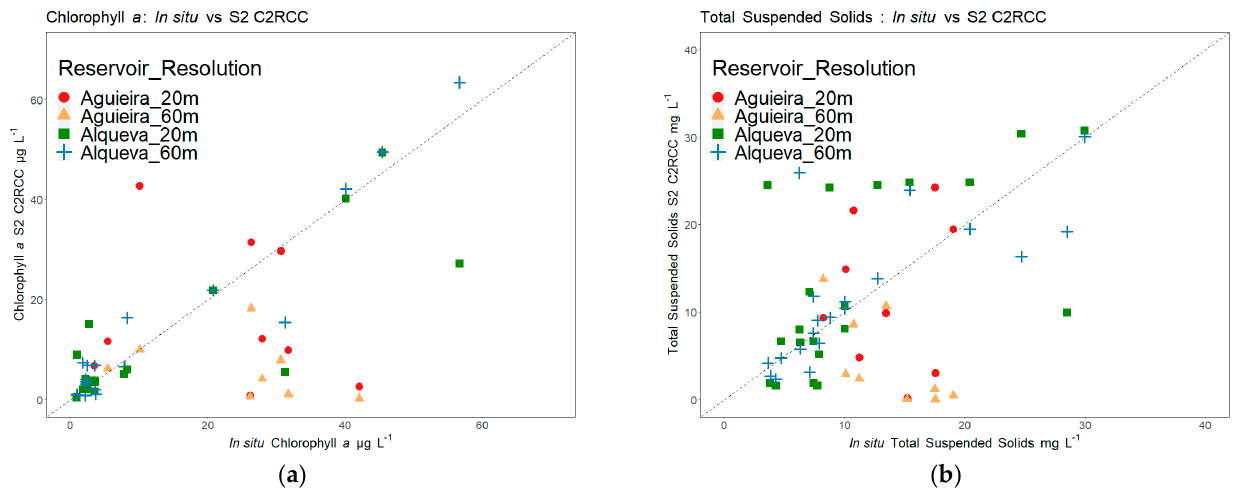
Figure 5. ( a ) Correlation between in situ and SNAP-C2RCC chlorophyll a values; ( b ) Correlation between in situ total suspended solids and SNAP-C2RCC total suspended solids values; a dashed X = Y line is also presented in each plot.